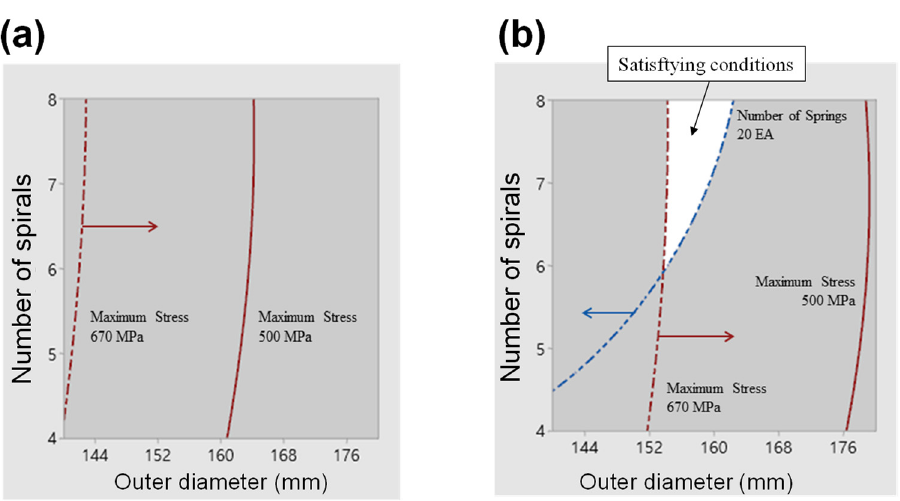
Figure 16. Optimization area at ( a ) 1.2 mm and ( b ) 1.5 mm spring thicknesses.